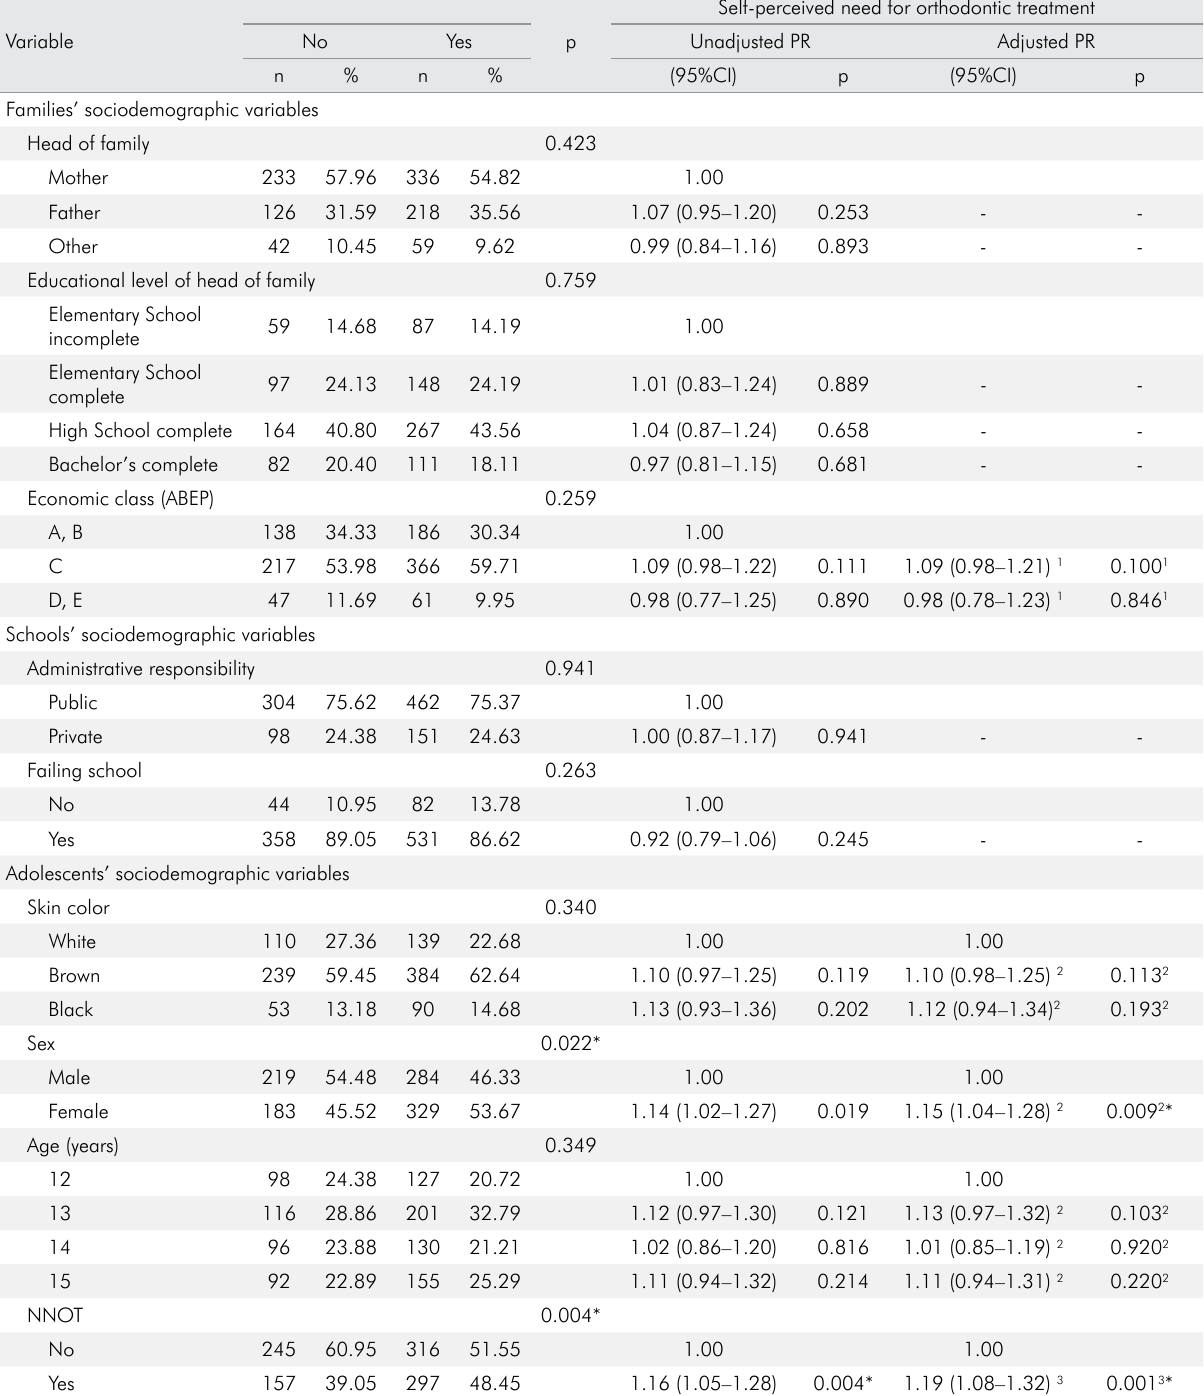
Table. Distribution and association of sociodemographic and oral health variables with Brazilian adolescents’ self-perceived need for orthodontic